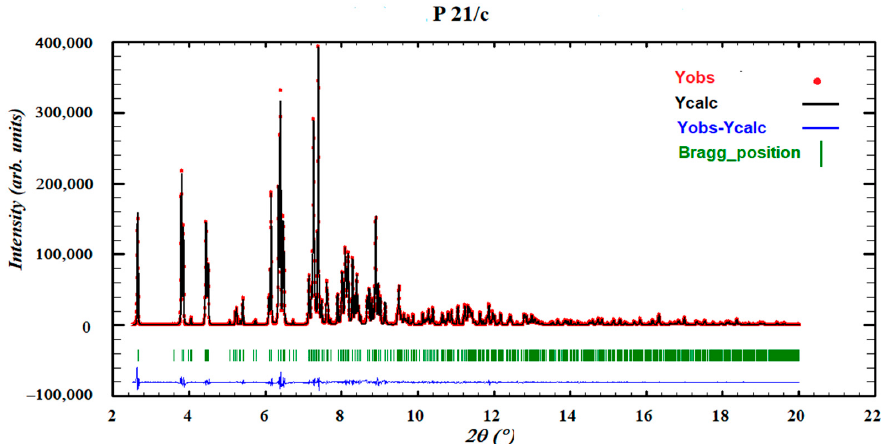
Figure 16. Pawley pattern matching plot of form II. Agreement factor: Rwp = 1.3%. The plot shows the experimental powder XRD profile (red+marks), the calculated powder XRD profile (black solid line) and the difference profile (blue, lower line). Tick marks indicate peak positions.